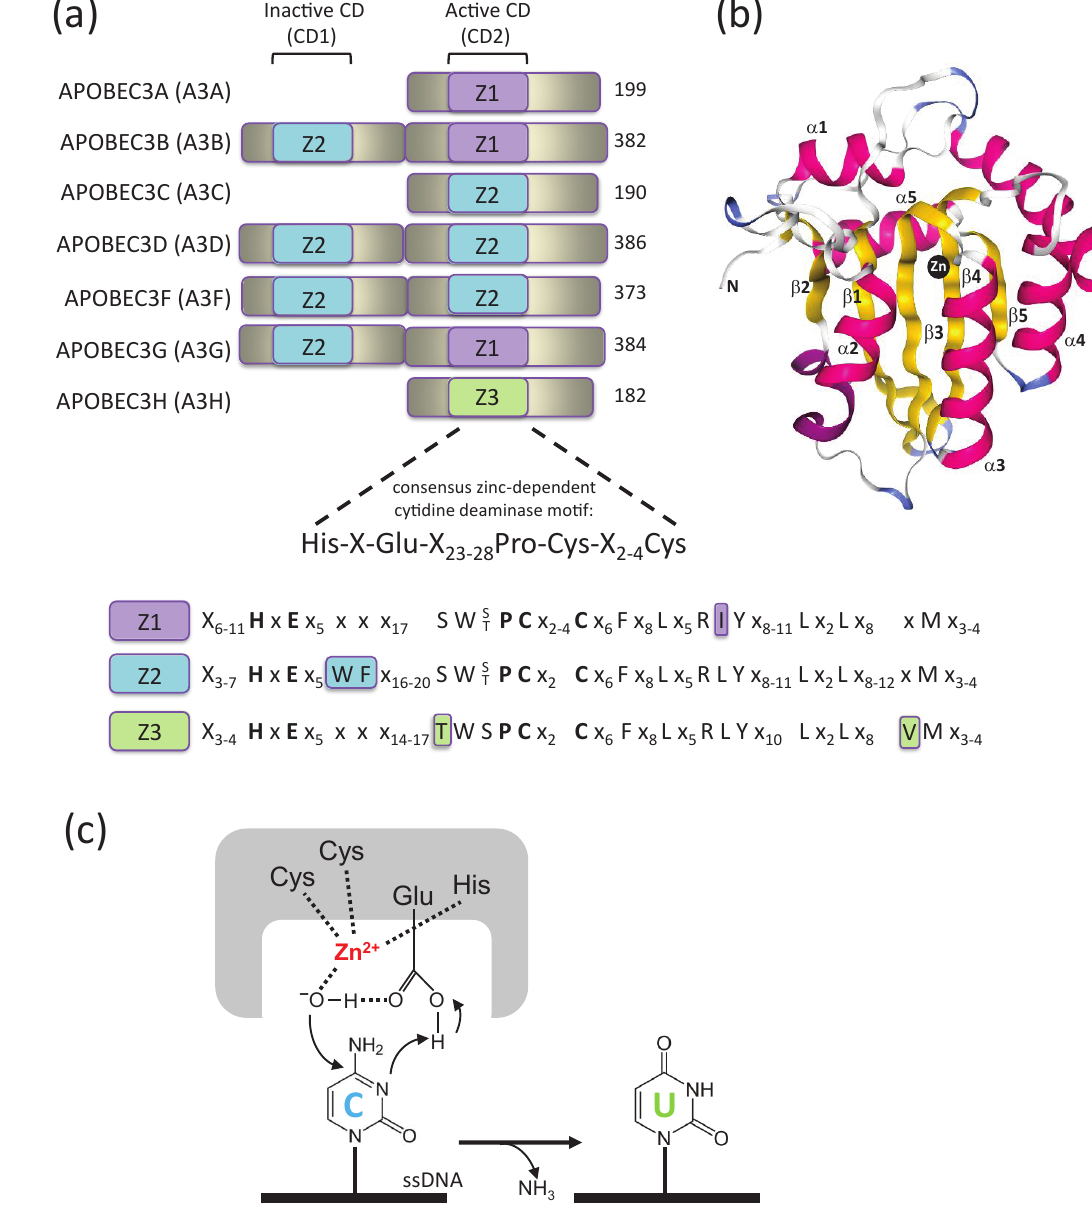
Figure 1. A3 domain organization. ( a ) Zinc-coordinating domains of A3A / B / C / D / F / G / H. A3 gene duplications have given rise to A3A / C / H with single Z-domains and A3B / D / F / G with two Z-domains. Numbers correspond to amino acid sequence length for each A3. Both the catalytically inactive and active Z domains contain the consensus motif H-X-E-X 23-28 -P-C-X 2-4 -C, which is structurally defined as starting at the loop3 / α -helix 2 junction. The amino acid similarity between the three Z domains (Z1, Z2, Z3) is shown, each with their distinctive amino acids highlighted. X represents any amino acid. ( b ) Crystal structure of A3 cytidine deaminase (CD) domain. Five β strands (yellow), six α helices (pink), and zinc atom (black) of the A3G catalytic domain are shown (PDB: 3IR2). ( c ) Mechanism of cytidine deamination proceeds by a direct nucleophilic attack on the C4 pyrimidine ring. In the catalytic site, cysteines and histidine together coordinate a zinc atom (Zn 2 + ), whereby a water molecule is hydrolyzed, donating a proton to the catalytic glutamate and forming a hydroxyl group. The glutamate acts as a proton shu ffl e during the catalysis, converting cytidine to